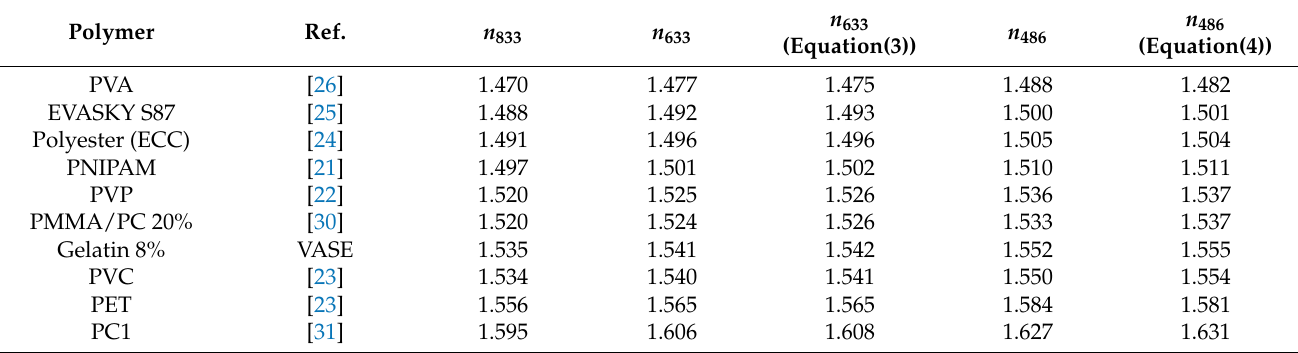
Table 1. Verification of the validity of our model to obtain n 633 and n 486 with equations (3) and (4), respectively, using experimental n 833 data taken from differences sources (indicated references). The calculated values are compared to the corresponding experimental ones reported in the same sources. Polymer